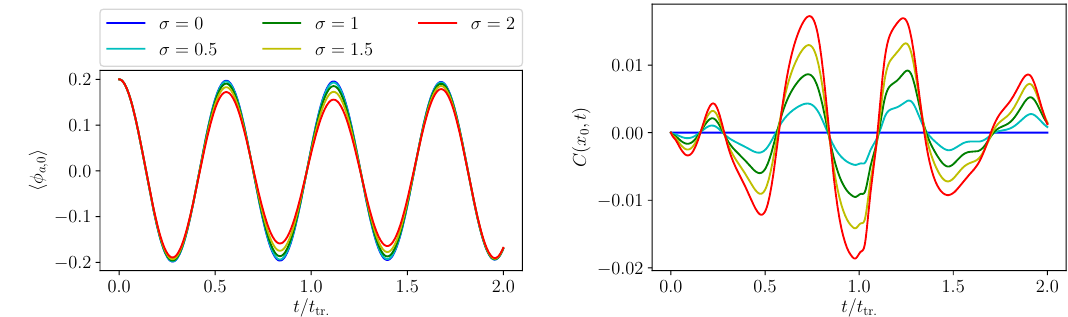
Figure 10: Time dependence of the space-averaged relative phase and the covariance C ( x , t ) (82) in the centre of the box for the profiles shown in panel (b) of Fig. 6. 0